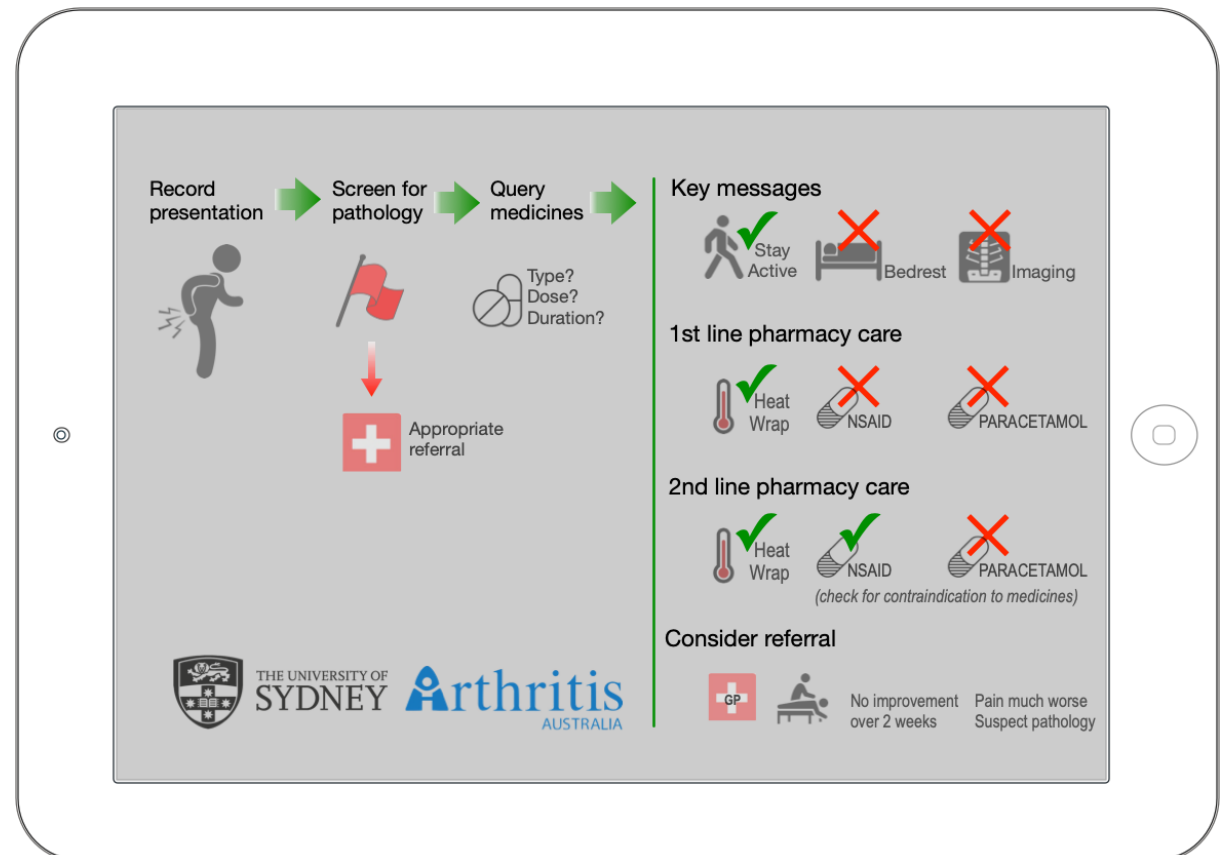
Figure 2. Clinical decision support system landing page showing clinical flow and scope of key messages. Tapping anywhere on this screen moves to the “clinical history”